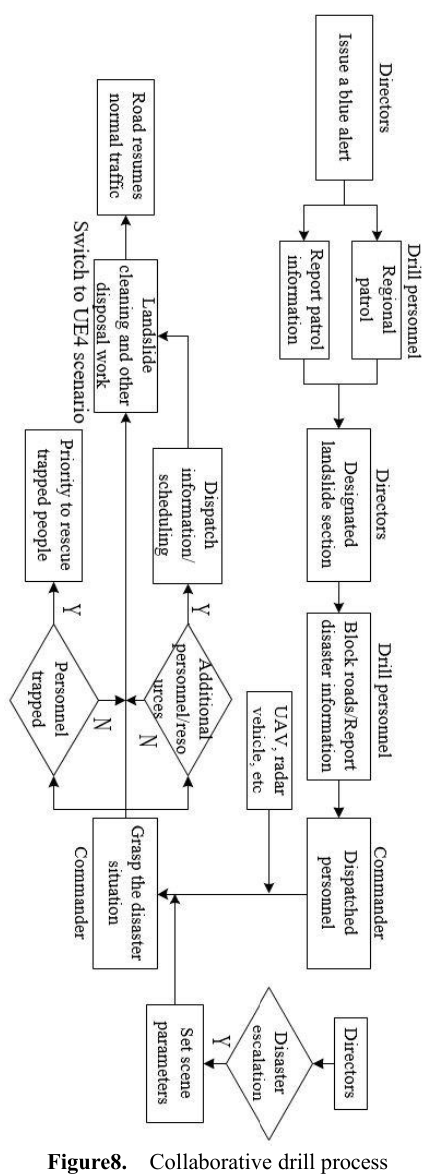
Figure8. Collaborative drill process